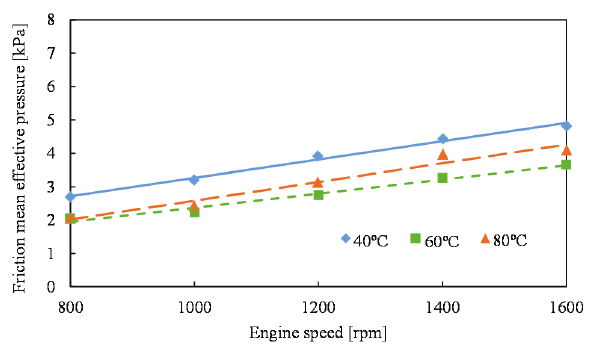
Fig. 13. FMEP with one-ring set without second and oil rings